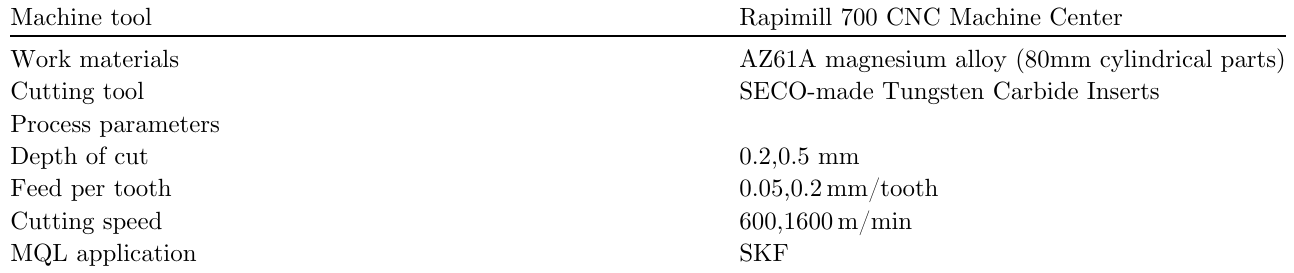
Table 1. Experimental set-up [30].